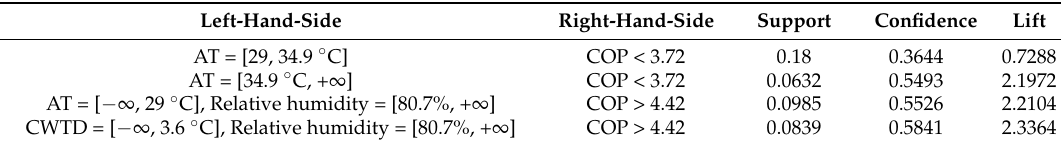
Table 5. Unexpected